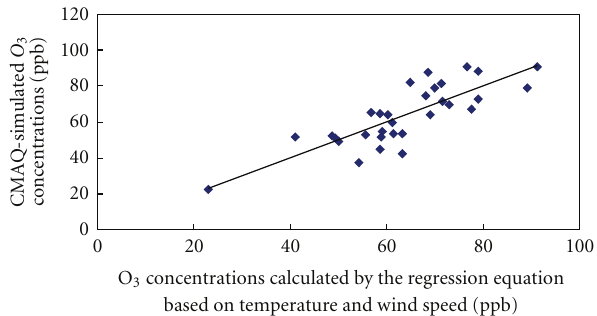
Figure 10: Simulated daily maximum O 3 concentrations for the Tokyo area plotted against those estimated by the regression equation based on temperature and wind speed.